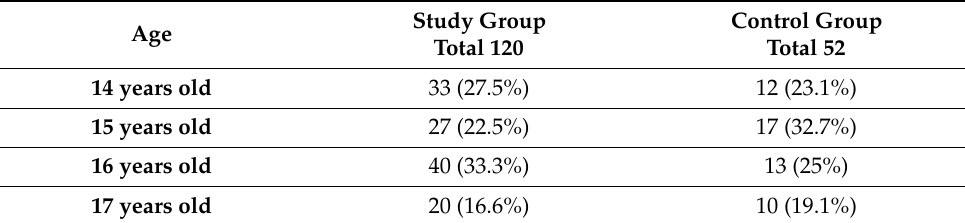
Table 2. Division according to age of both study and control groups.